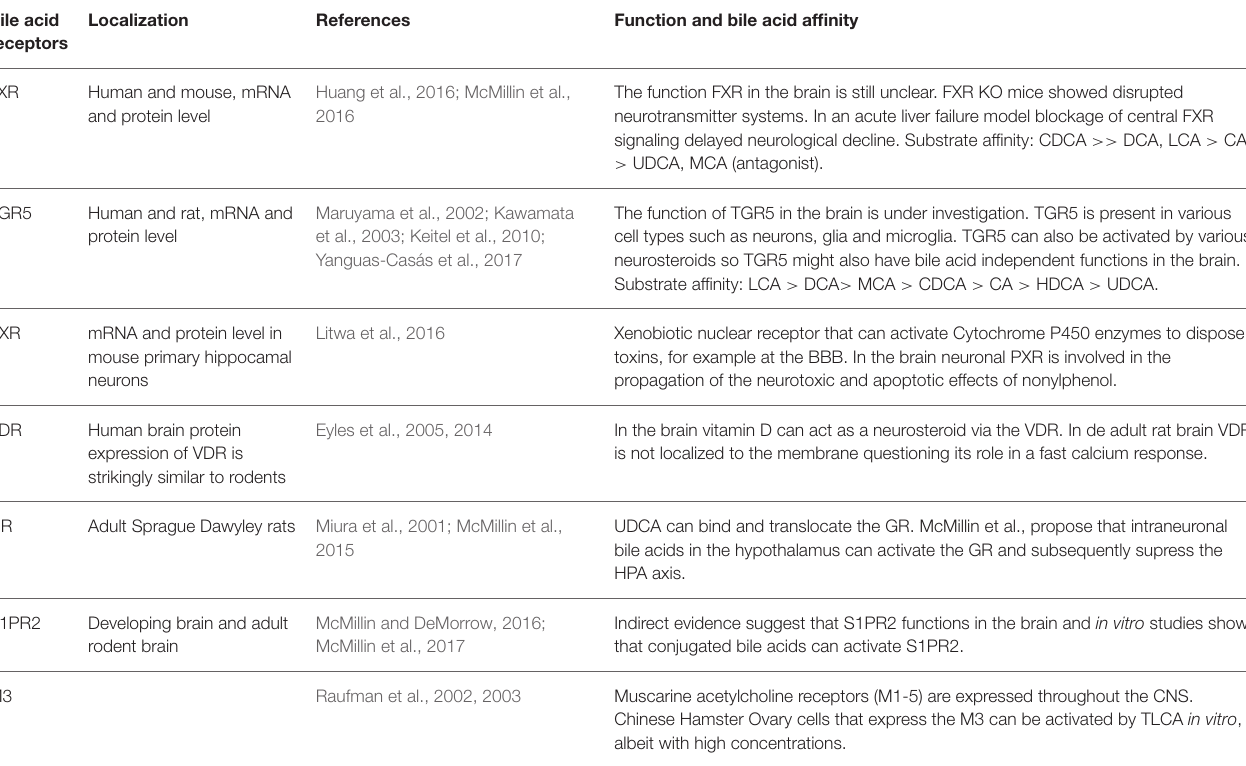
TABLE 3 | Bile acid receptors found in the